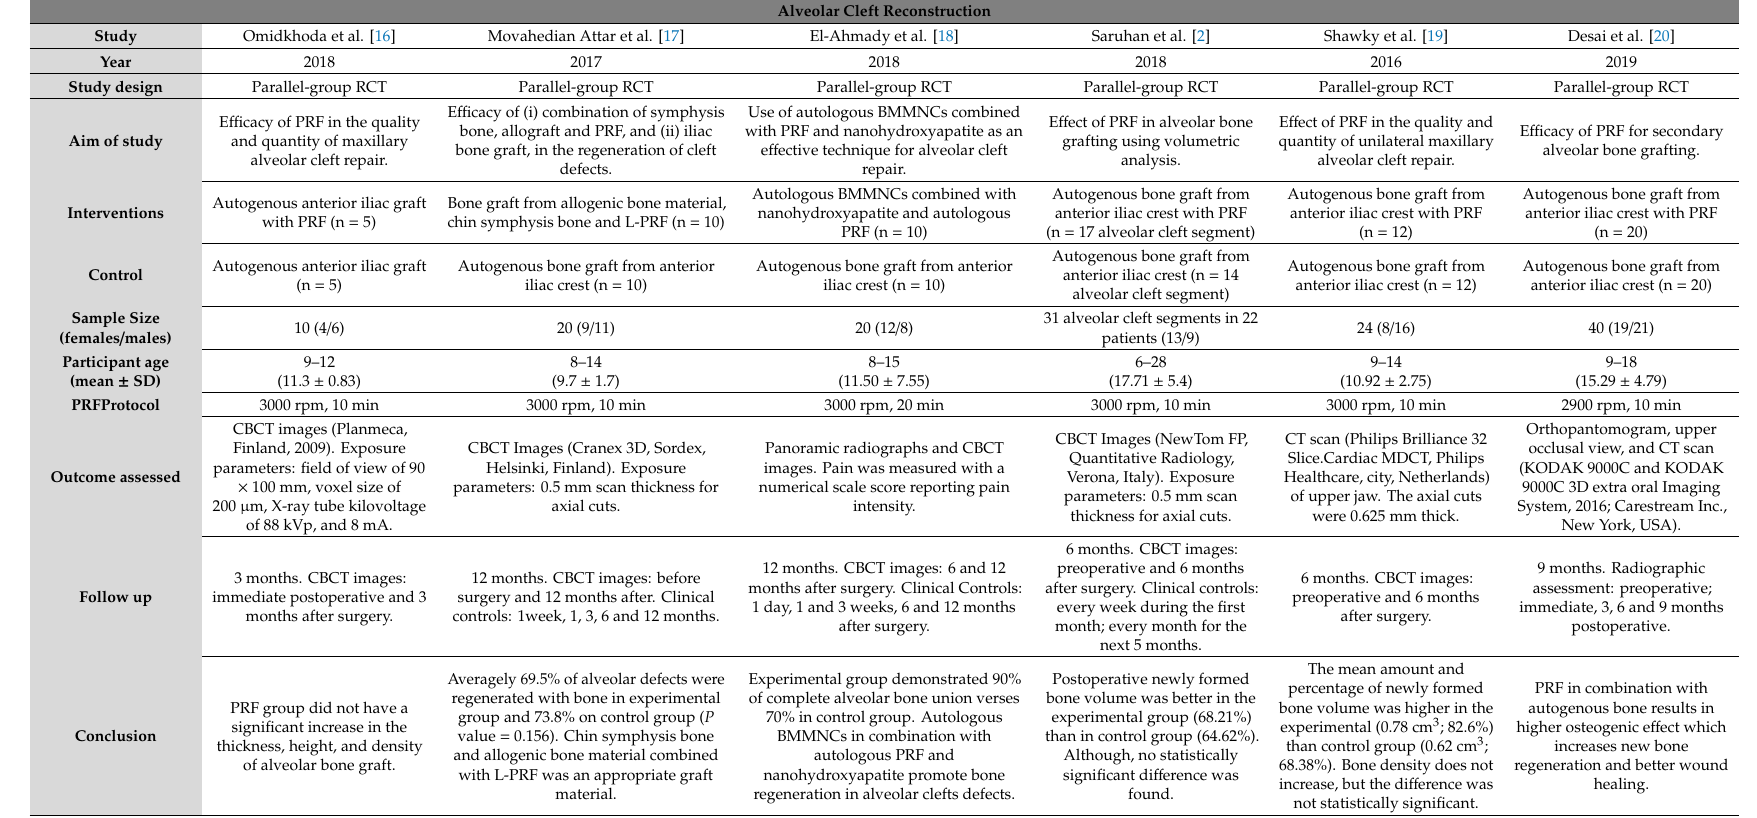
Table 2. Characteristics of included studies on alveolar cleft